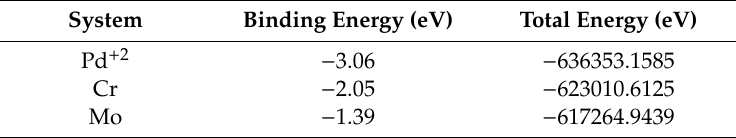
Table 1. Binding energies and total energies of the nanoballs.